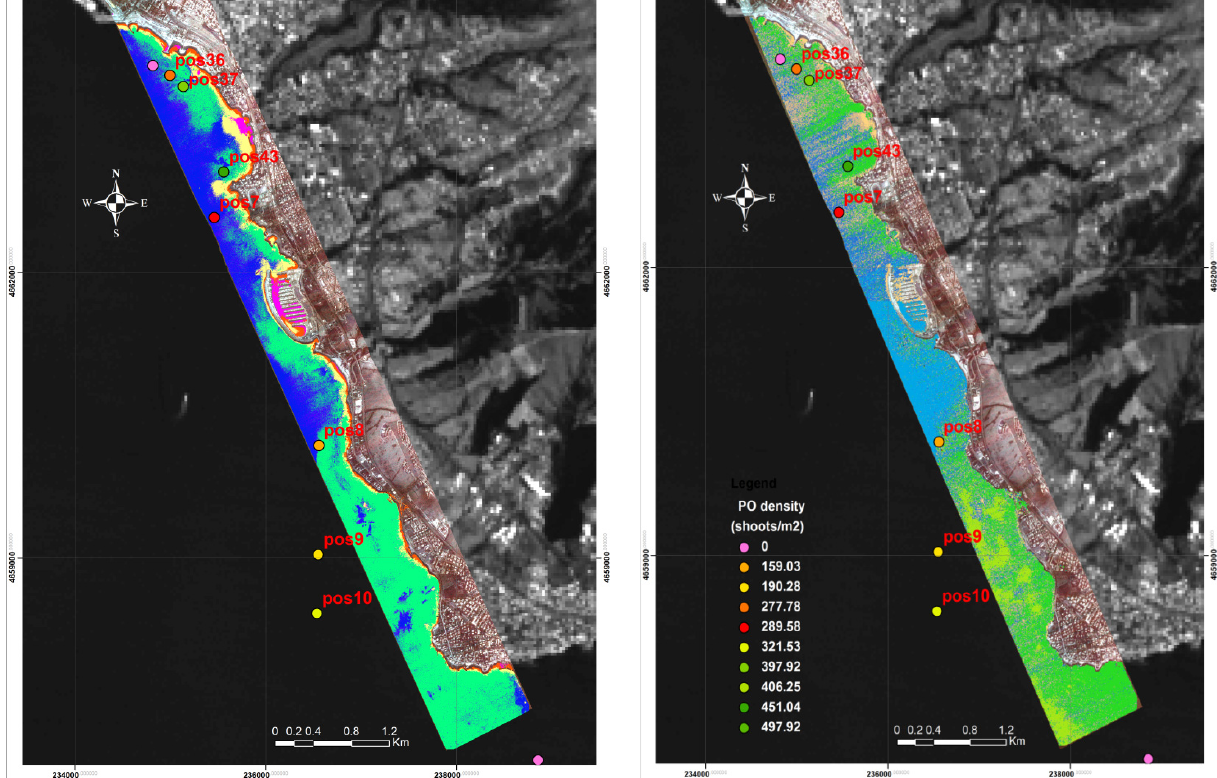
Figure 7. Thematic maps of PO distribution (green shades) along the Civitavecchia coast obtained by means of SAM classification of atmospherically corrected Daedalus ATM 1268E ( Left ) strip data and of derived Lyzenga’s SBRI five indices ( Right ). The PO sampling station point density (shoot/m 2 ) classes are reported in overlay as colored dots representing local PO density while a ETM+ band 4 was used as gray shades background. Cartographic Projection: UTM zone 33N, Ell./Datum: